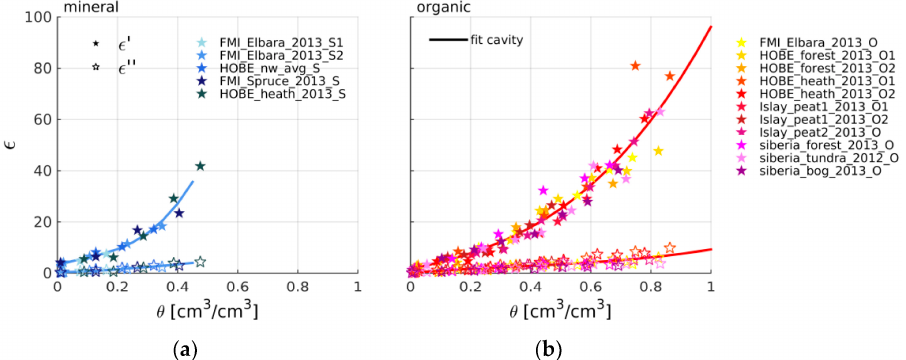
Figure 3. Estimated permittivities, ( a ) real ε′ and ( b ) imaginary ε″ part, of all organic samples measured over the entire wetness range θ and at room temperature (filtered as specified in Section 2.2.3), using a filling factor α for the full tube length (grey) and specifically calibrated for the 4 cm tube insertion depth (red).